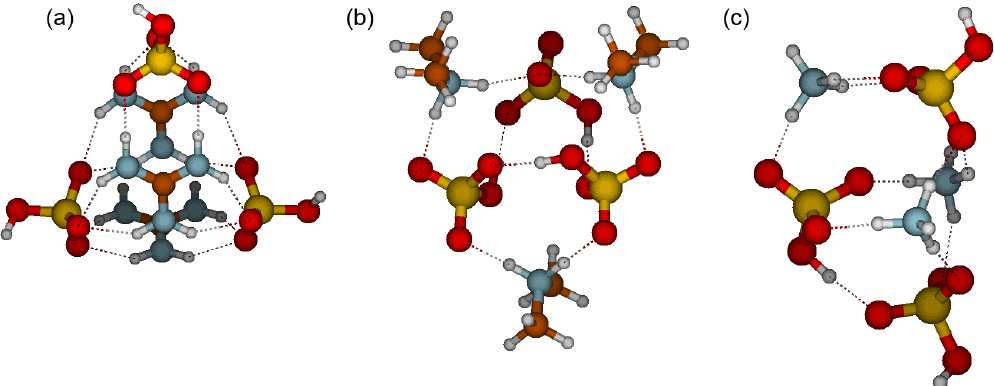
Figure 4. Molecular structures of clusters containing three sulfuric acid and three base molecules for guanidine (a) , dimethylamine (b) and ammonia (c) . Color coding: brown is carbon, blue is nitrogen, red is oxygen, yellow is sulfur and white is